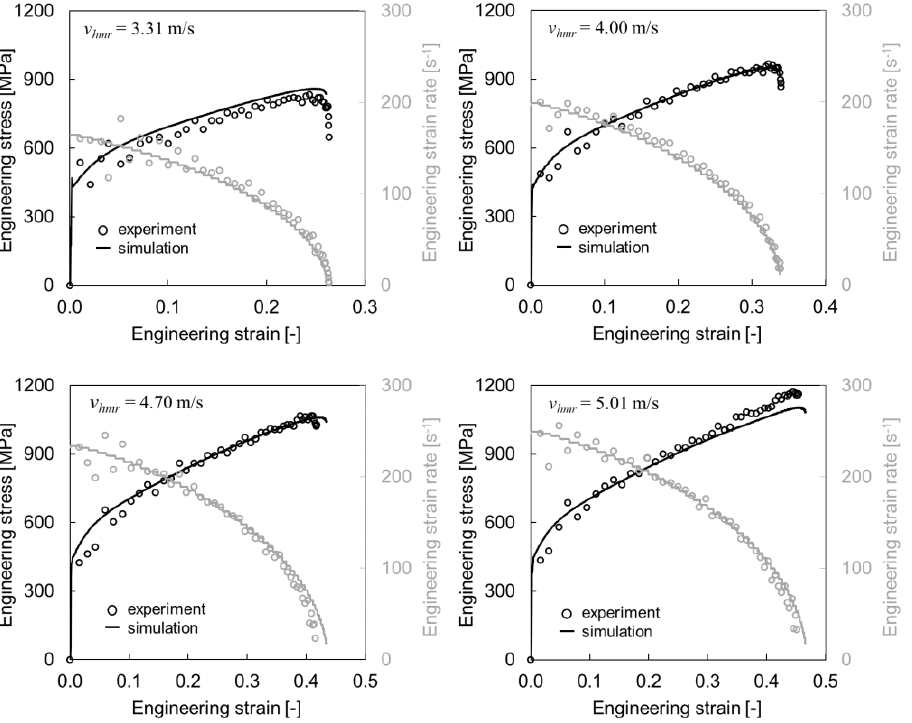
Figure 3. Engineering stress-strain and engineering strain rate-strain curves for the four impact velocities compared with their corresponding numerical